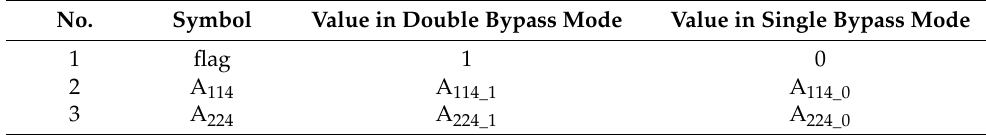
Table 2. Control variables with fixed values in double bypass mode and in single bypass mode.